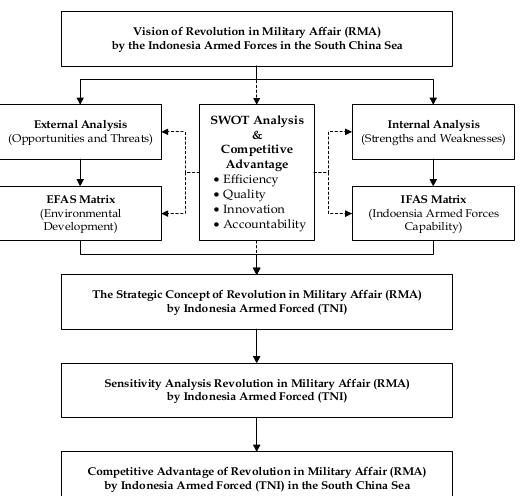
Fig. 2. The Conceptual Framework for the Development of the Indonesian Armed Forces Strategy in the South China Sea The development of the RMA concept strategy on the Indonesian Armed Forces' capabilities towards Competitive